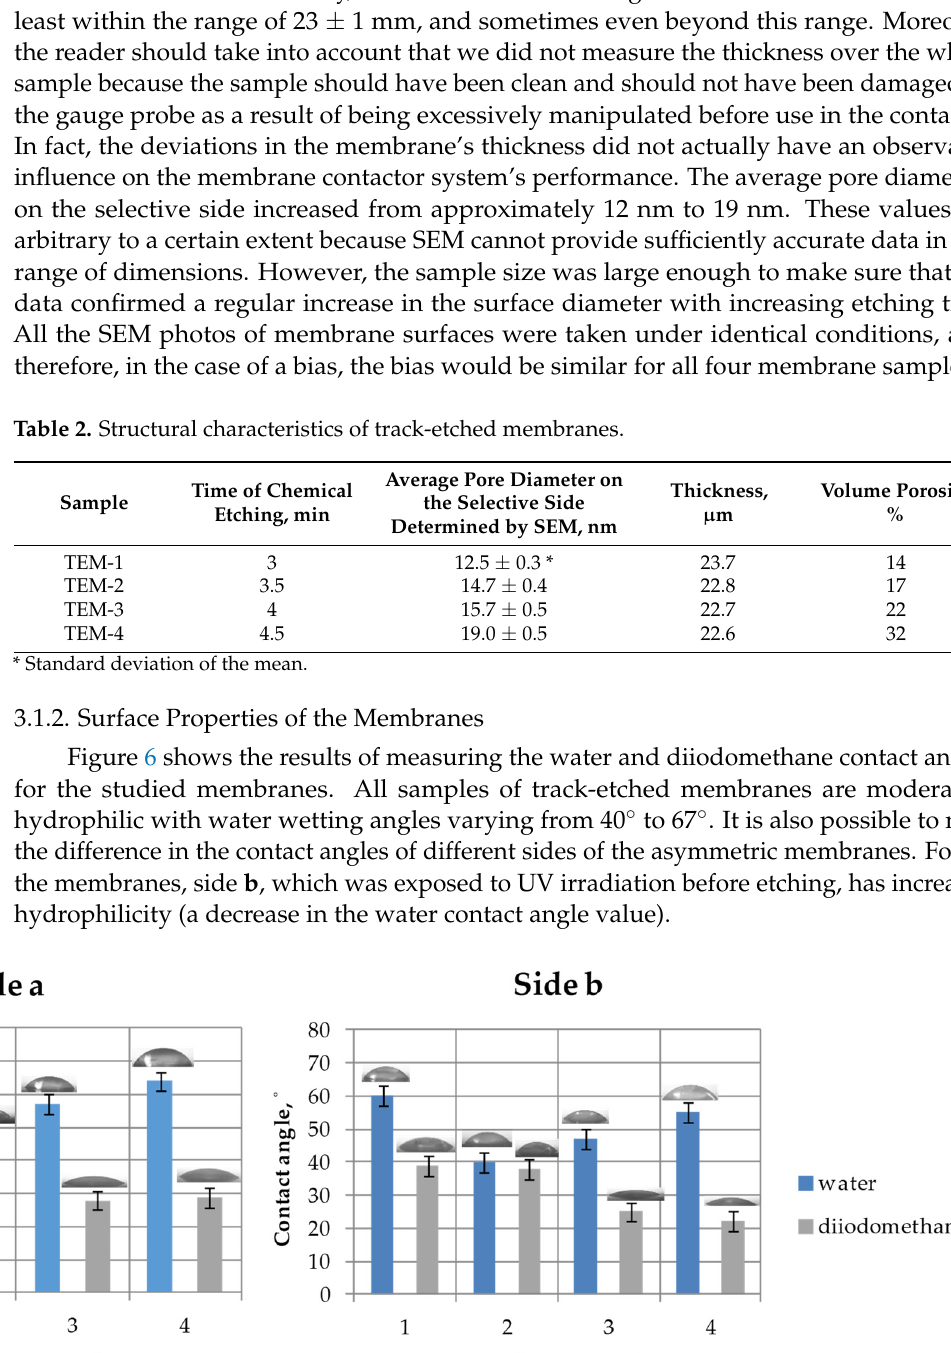
Table 3. The surface energy of the membranes.